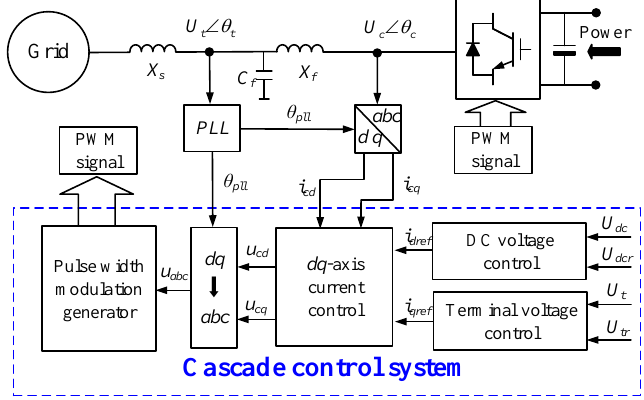
Figure 1. Topology and control system of grid-tied voltage source converter (GVSC).